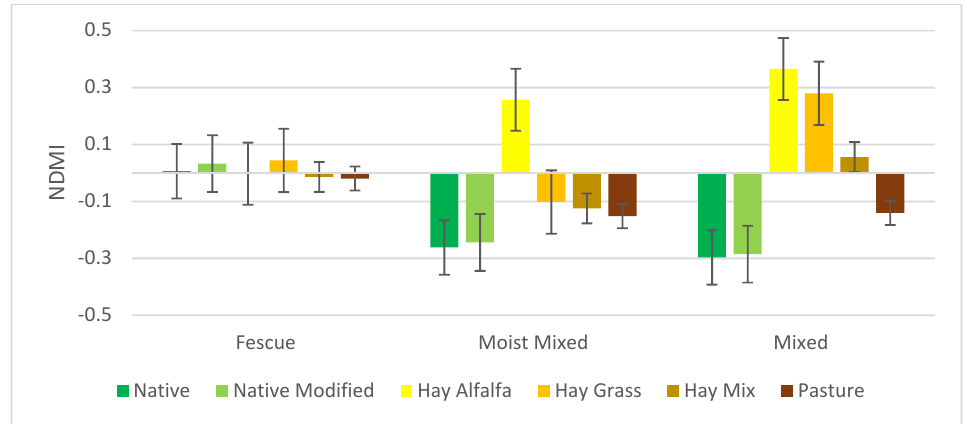
Figure 4. Mean and standard deviation of NDMI values for the grassland/forage land classes in the three ecoregions.